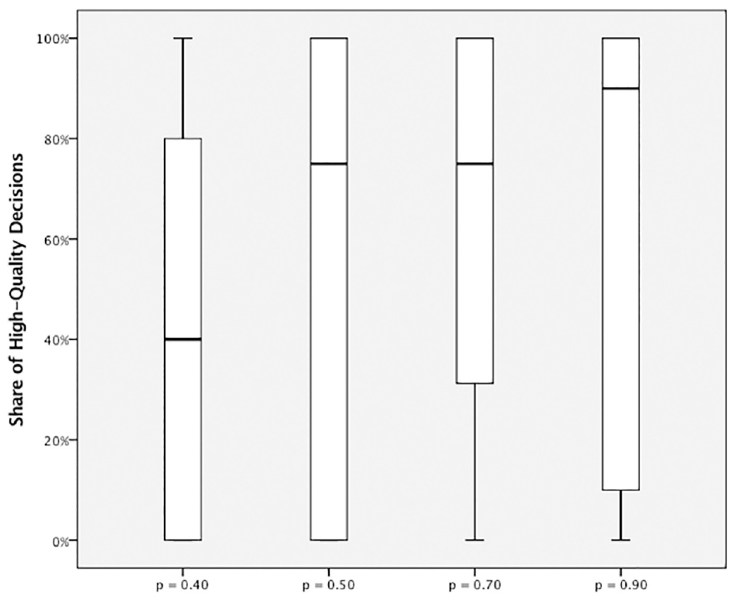
Table 5. The general trend is: the higher the probability of being confronted with an unrealistic deadline, the more likely do subjects decide to deliver high quality (in cases they are actually confronted with an unrealistic deadline).